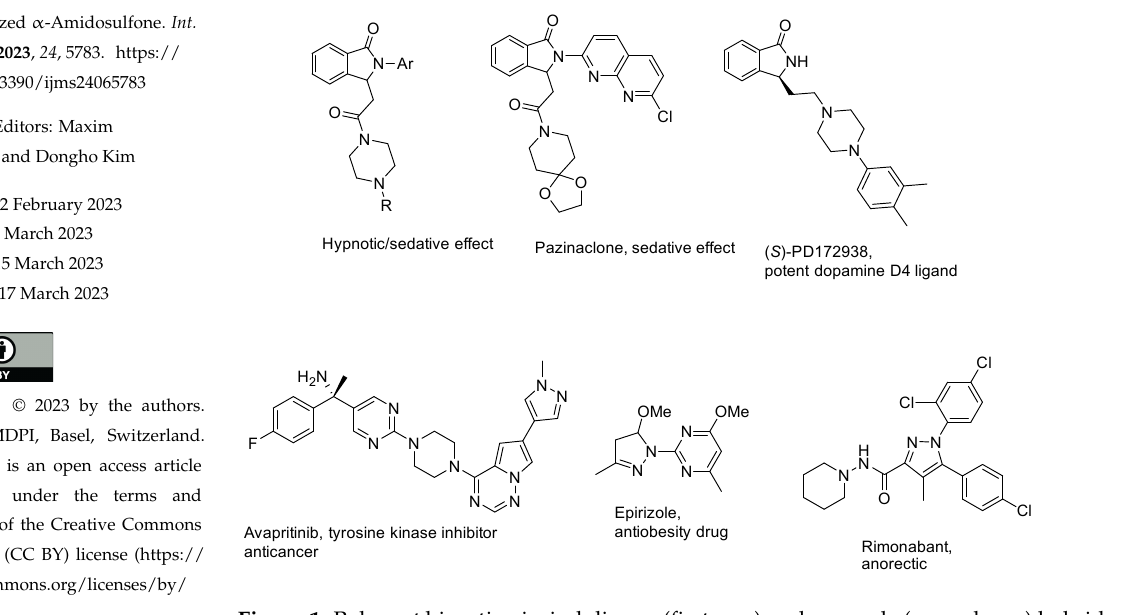
Figure 1. Relevant bioactive isoindolinone (first row) and pyrazole (second row) hybrids.